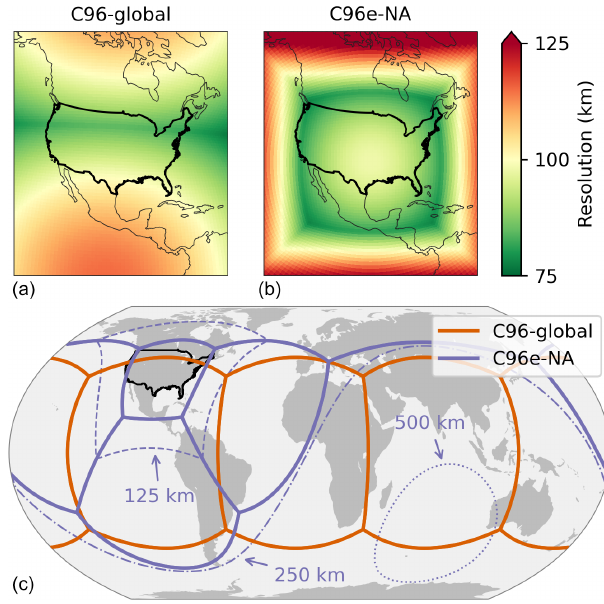
Figure 4. Comparison of C96-global and C96e-NA grids. The top panels show the variability of resolution for both grids. The bottom panel shows the grid face edges for C96-global and C96e-NA, with the 125, 250, and 500km resolution contours for